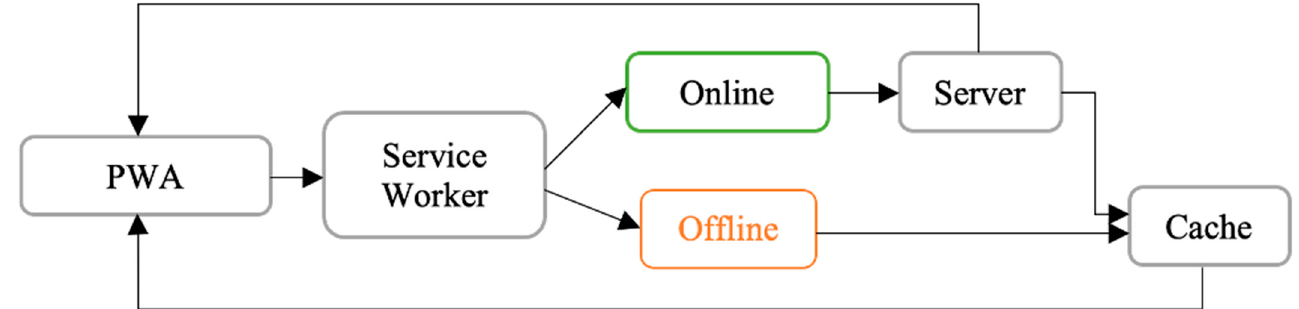
Figure 3. Caching mechanism